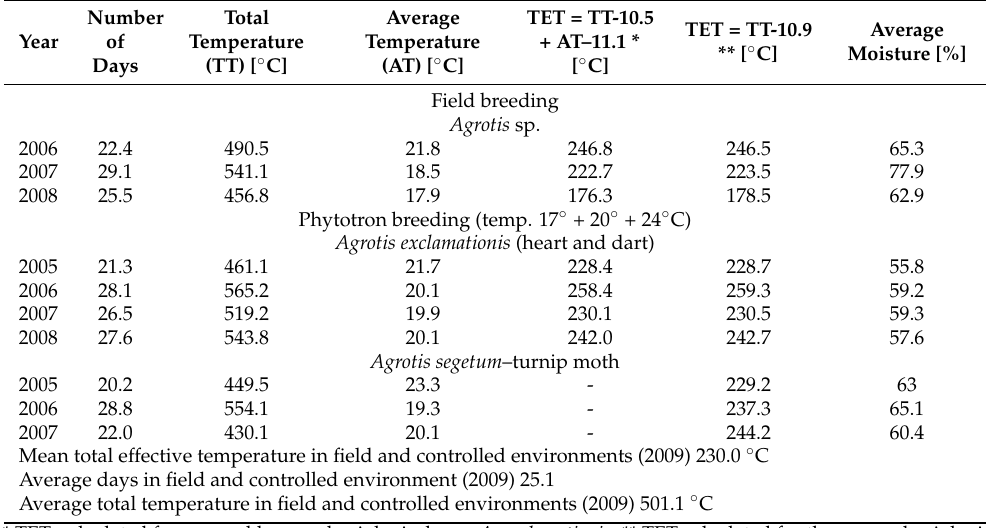
Table 2. Winna G ó ra research findings accounted for in the Agrotis spp. control study for